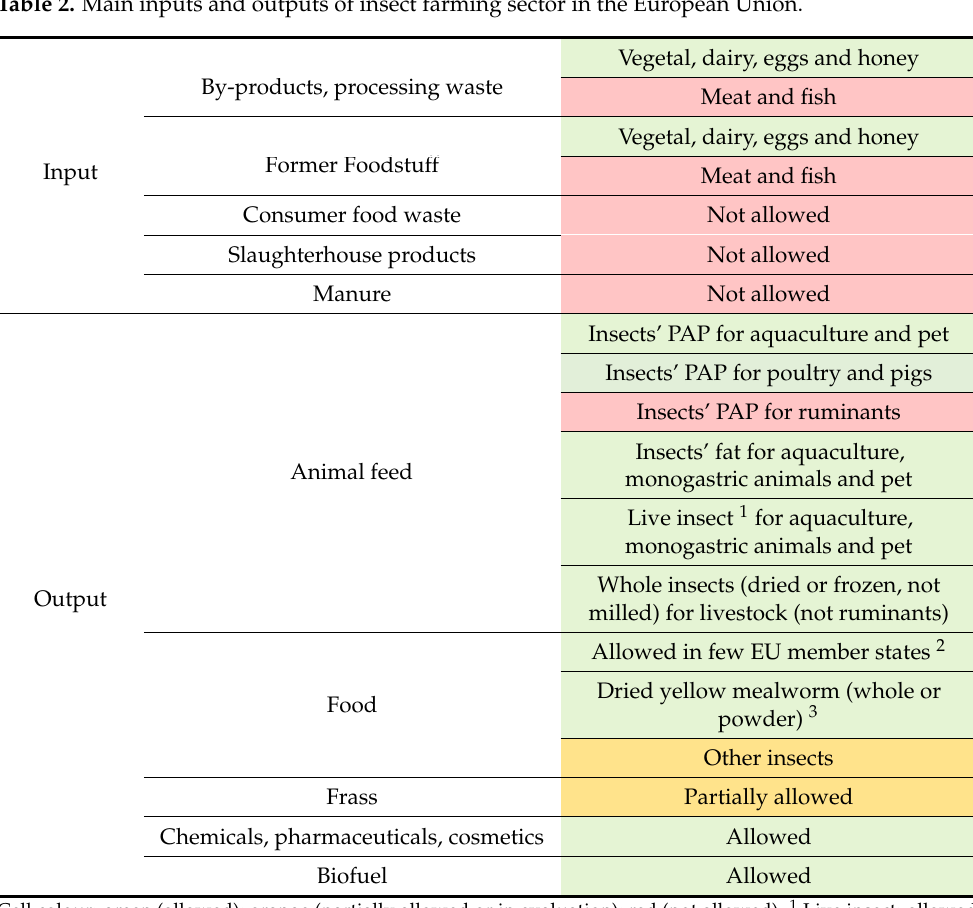
Table 2. Main inputs and outputs of insect farming sector in the European